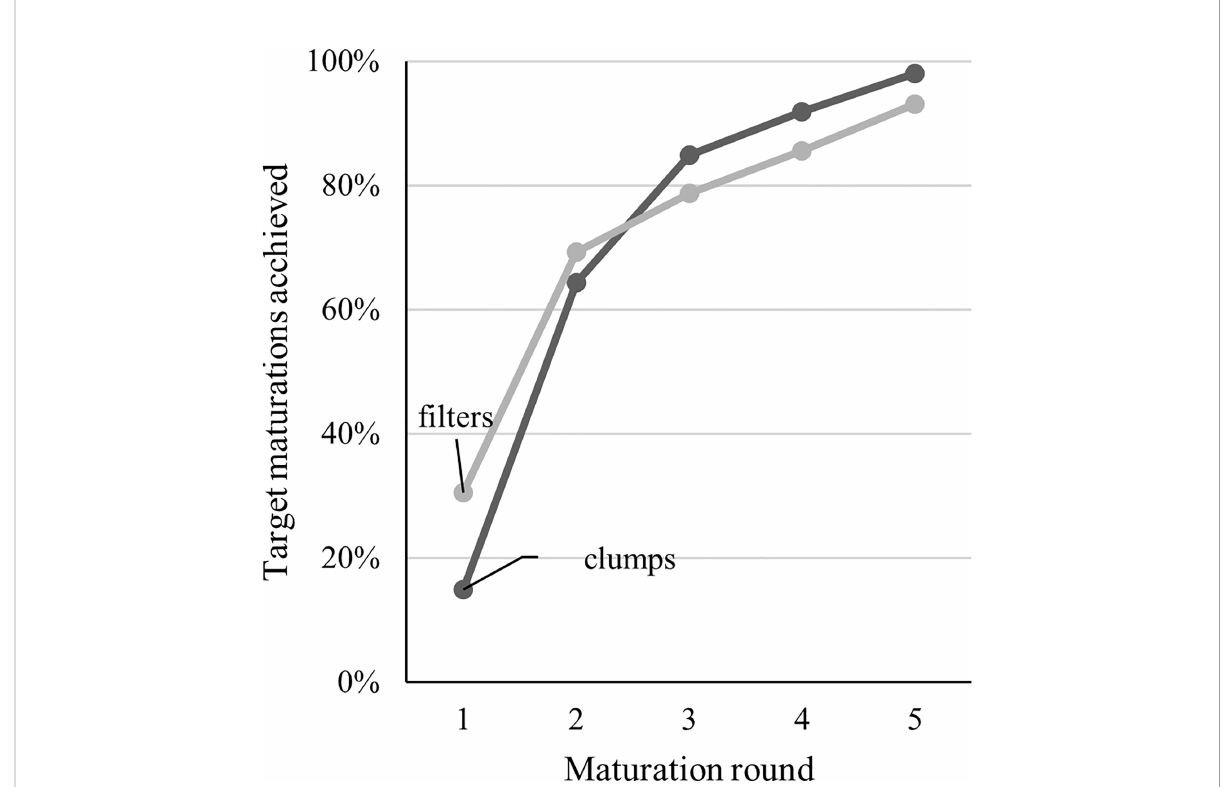
FIGURE 2 Visualization of maturation progress in Trial III with two weeks between each maturation round. In Trial III, the goal (100%) was to get 40 maturation plates from all 19 lines used in the trial for both clump and fi lter proliferation. The factor limiting the progress was the amount of ET in the proliferation